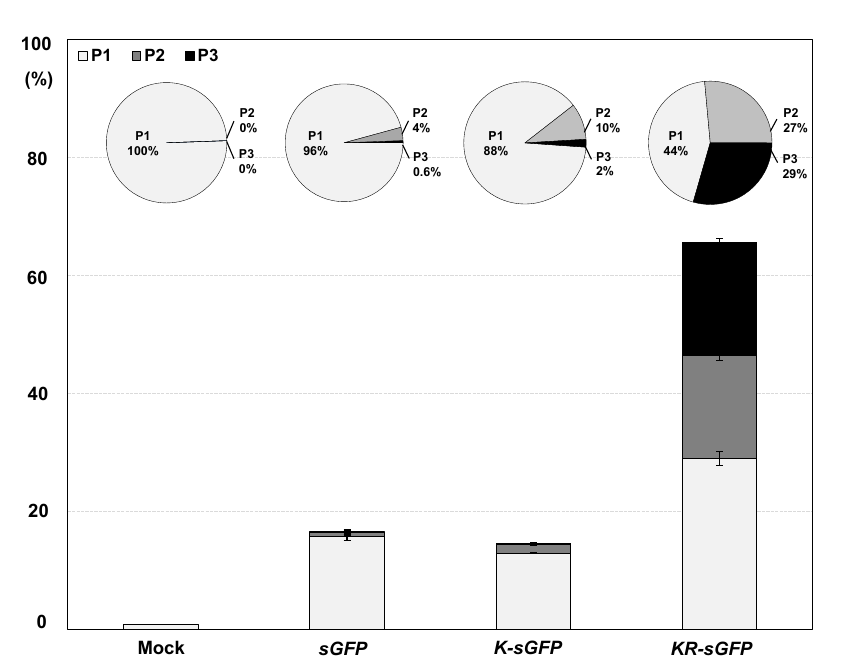
Figure 3. The relative proportional subpopulation distribution of protoplast expressing sGFP. The fluorescence intensity was partitioned into P1, P2, and P3 subpopulations (P1: 10 3 –10 4 ; P2: 10 4 –10 5 ; P3: >10 5 ). The total percentage of protoplasts expressing sGFP on FCA is shown by the sum of percentages of transfected cells on each